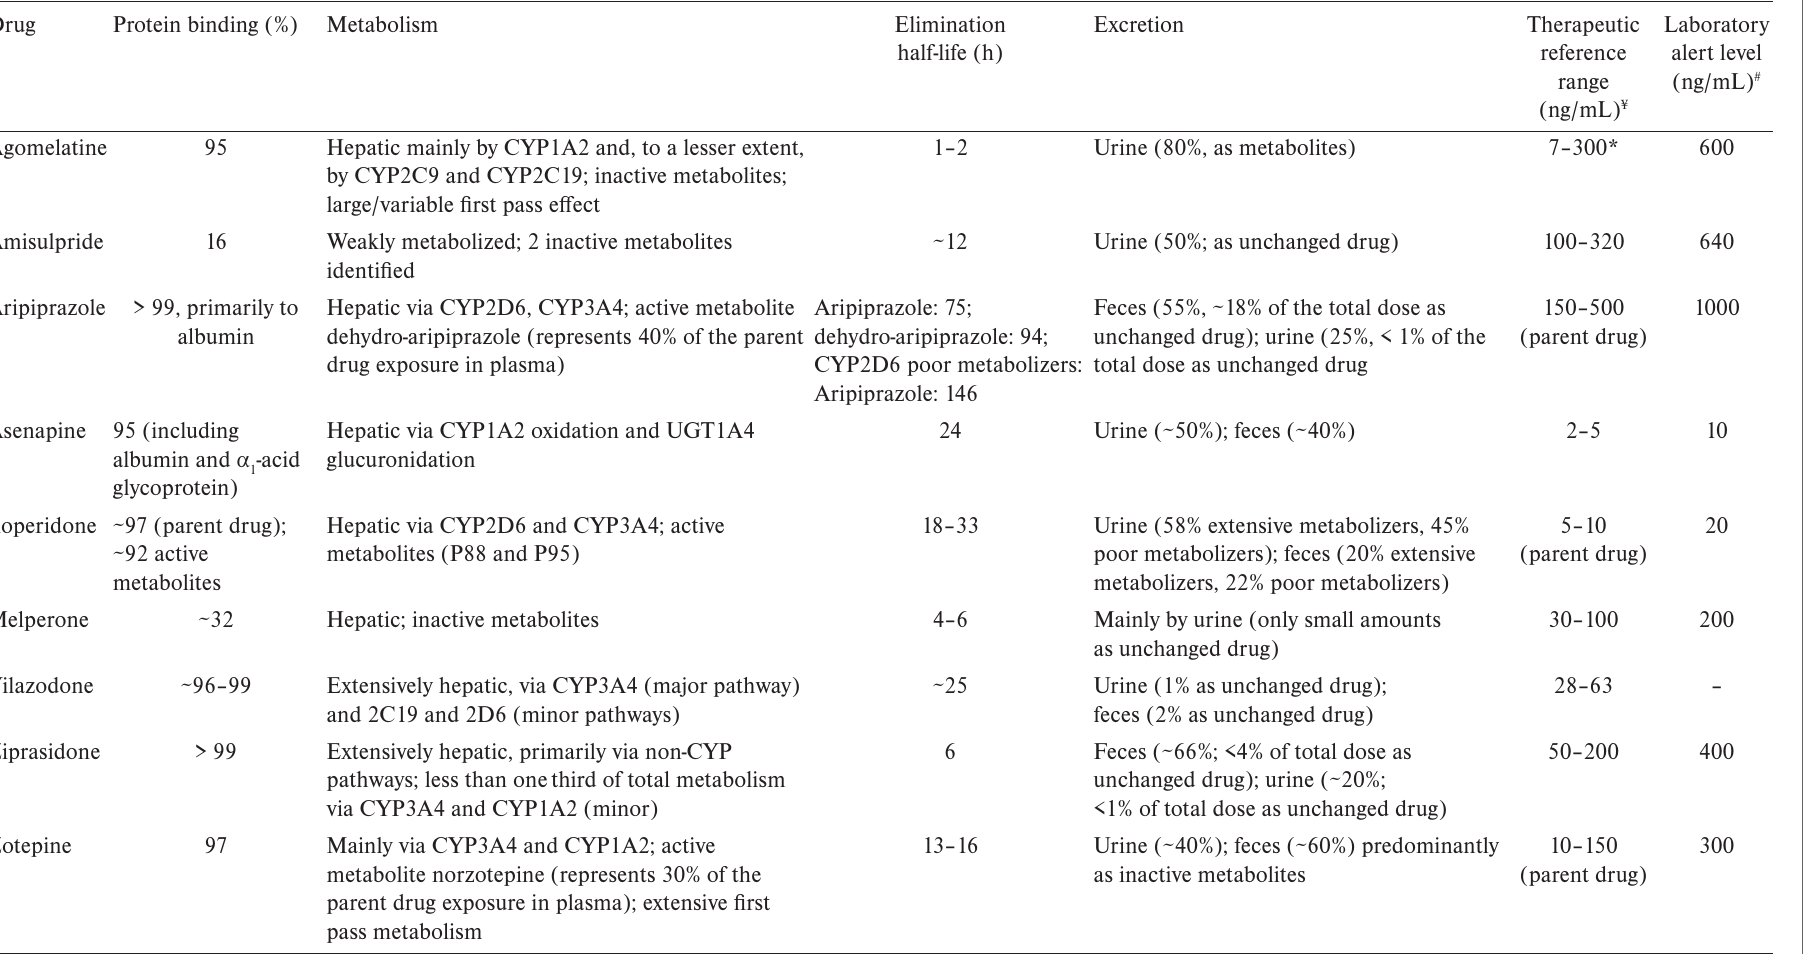
Table 1. Selected pharmacokinetic and TDM characteristics of the described psychotropics 17,7,18,19